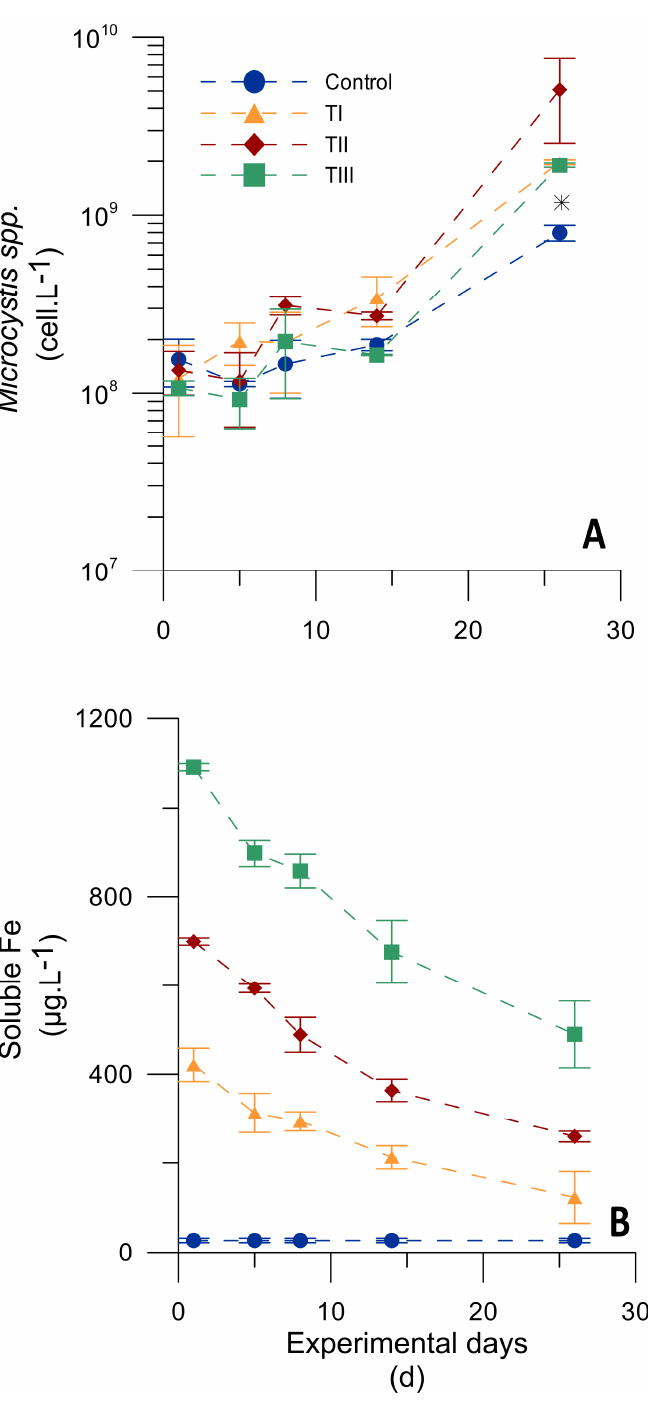
Figure 2. Cell abundance (cell·L −1 ) ( A ) and soluble iron concentration (µg·L −1 ) ( B ) in Microcystis spp. natural populations from sample-2017 under different treatments during the first experiment. Control, without iron addition (27 ± 5 µg Fe·L −1 ); TI: +400 µg Fe·L −1 ; TII: +700 µg Fe·L −1 ; TIII: +1100 µg Fe·L −1 . Values are the mean of triplicates, and vertical lines above symbols are standard deviations. Asterisks are located above the treatments that showed a significant difference in cell abundance in comparison with that in the other treatment groups ( A ).